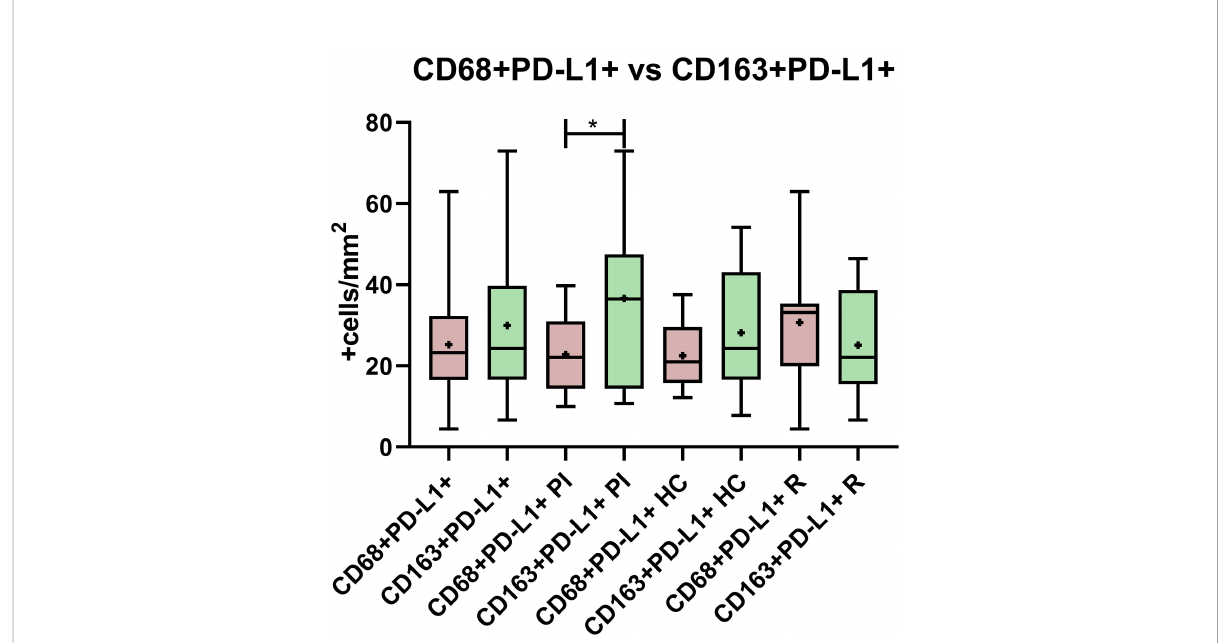
FIGURE 3 PD-L1 expression comparison between CD68 and CD163 macrophages in the entire cohort, in primary infected patients (PI), healthy carriers (HC), and patients undergoing reactivation (R). *p < 0.05.